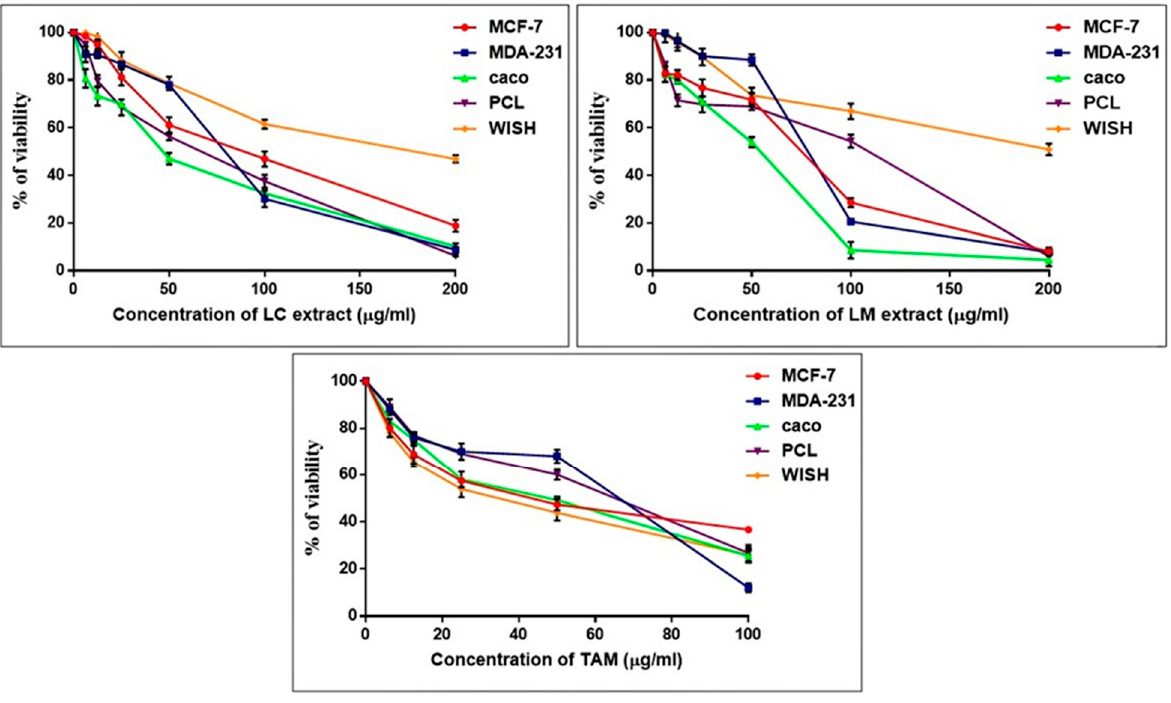
Figure 4. The cytotoxic effects of L. camara , L. montevidensis , and tamoxifen (standard) on different cancer cell lines. Cells were treated with various concentrations of L . camara , L. montevidensis , and tamoxifen for 48 h and cell viability was plotted against drugs concentration to calculate the IC 50 . Results were expressed as mean ± SE, ( n = 5).